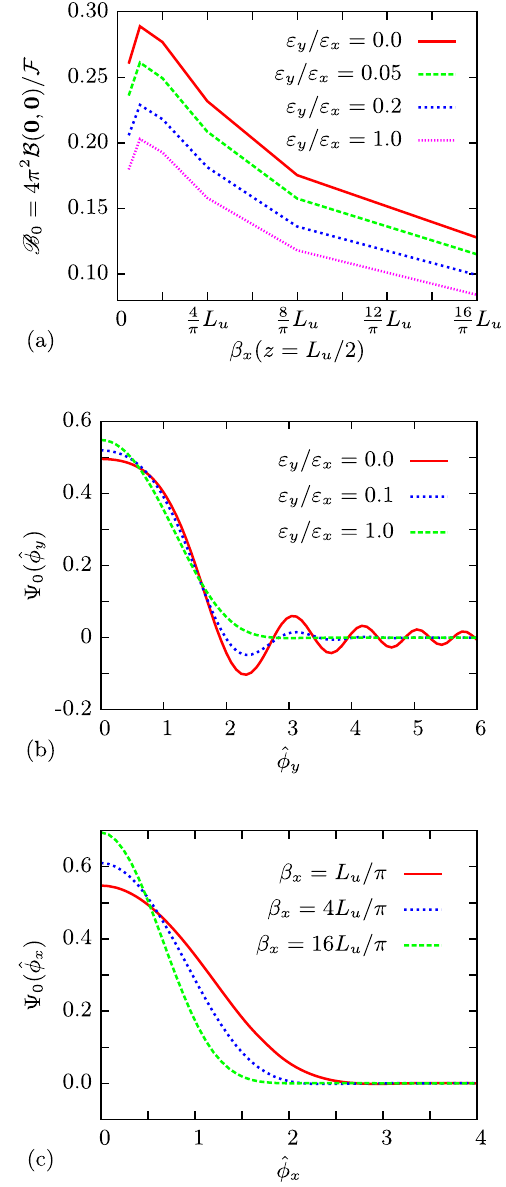
8. (a) Coherence metric ℬ 0 as a function of the e-beam focusing for various emittance ratios. (b) Field profile along y of the lowest order coherent eigenmode for different L = π . Ψ 0 ð ϕ emittance ratios when β is qualitatively the x ¼ u y Þ same at different β . (c) Ψ 0 ð ϕ for various e-beam focusing x x Þ 0 ; this profile is nearly independent of the emittance when ε y ¼ ratio when ε 0 ¼ λ = 2 π